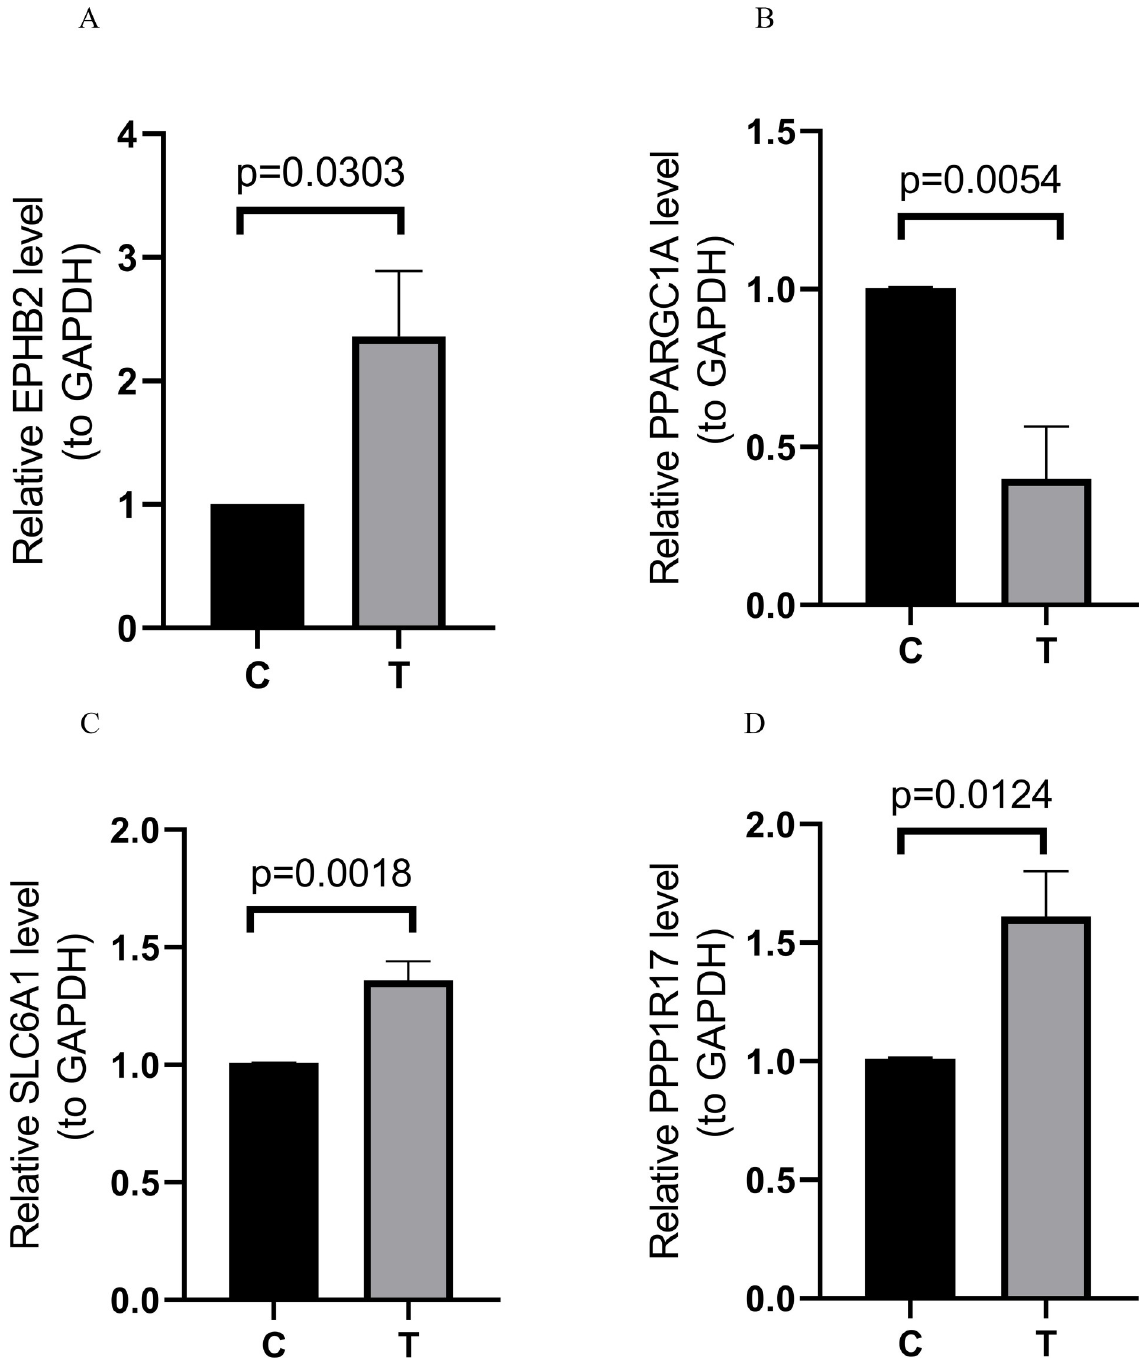
Fig 10. Expression of MRGs in 10 sets of tissue (T, COAD tissue;C, adjacent tissue). (A) EPHB2, (B) PPARGC1A, (C) SLC6A1, (D)